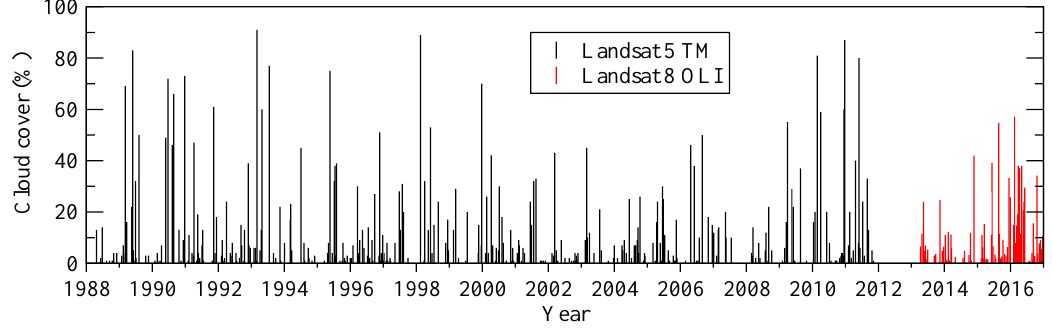
Figure 4. The time series plot of the cloud cover percentages of all the downloaded Landsat 5 TM (black) and Landsat 8 OLI (red) images.